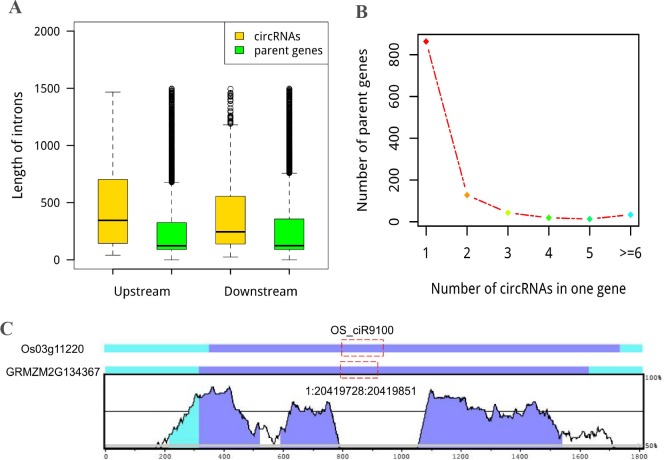
The genomic character and conservation of circRNAs.(A) Mean length distribution of upstream and downstream intron flanking circularized exons in Z.mays. Longer intron bracketing circularized exons was observed than the parent gene. (B) The number of genes (y-axis) that generated different numbers of circRNAs (x-axis). (C) An example of sequence conservation analysis of circRNAs between O. sativa and Z. mays. Y-axis, levels of conservation based on genomic sequence similarity. The locations of circRNAs in their respective parent genes are marked with a red box. Conserved regions are labelled in different colours by VISTA according to the annotations (exons in blue shadow, UTR in cyan shadow and CNS (non-coding sequences) in red shadow).